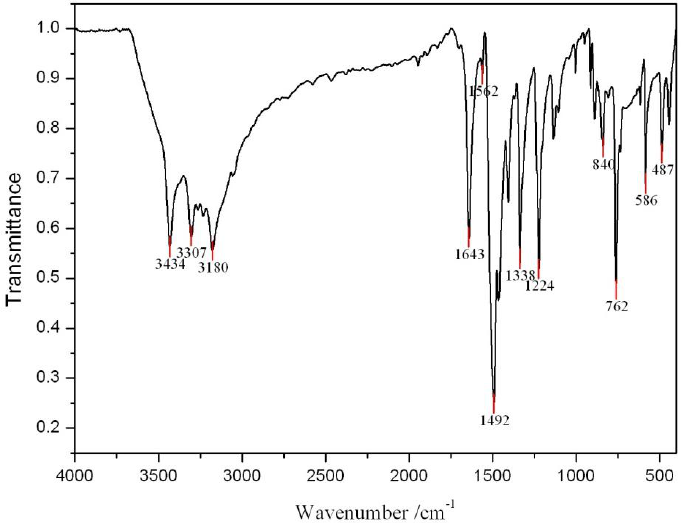
Figure 3. FT-IR absorption spectrum of the product.